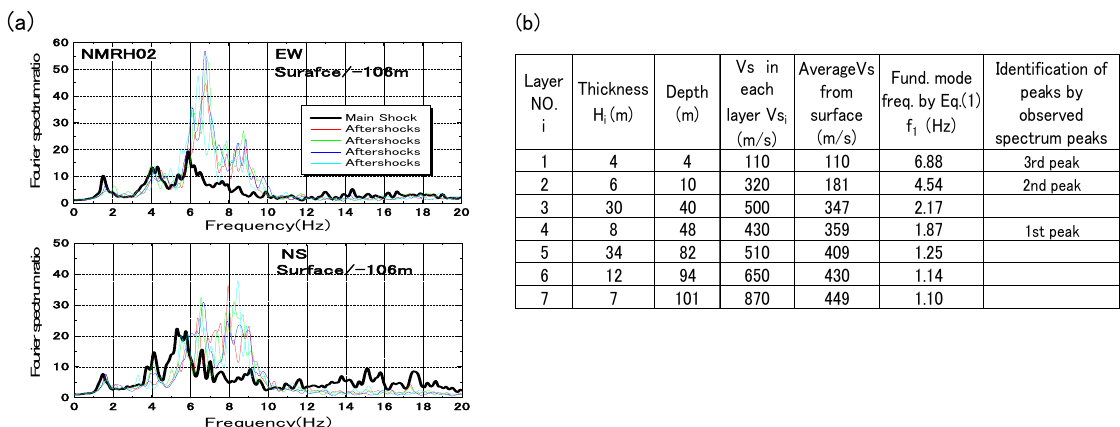
Figure 8. Fourier spectrum ratios of observed motions EW & NS ( a ), and Soil/ V s -profiles compared with spectrum peak frequency ( b ), at IBUH03 during EQ3. 4. S-Wave Velocity Ratio versus Site Amplification A flow chart is illustrated in Figure 9a to develop a reliable correlation between site amplification and S-wave velocity based on the vertical array database in this research. Totally 39 mainshock records have been selected out of 118 during eight earthquakes initially addressed as listed in Table 1. The following two criteria was employed in the selection to reduce various potential errors involved during the data reduction process.